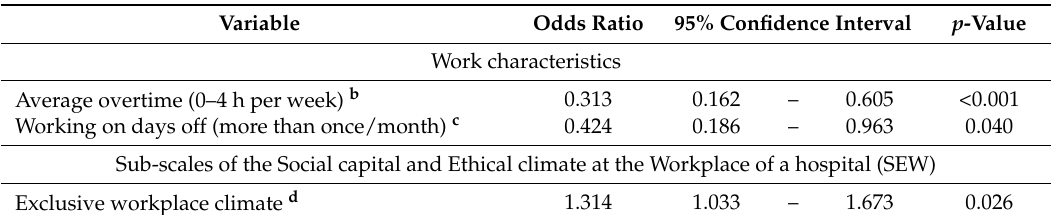
Table 5. Multivariate logistic regression model for the experience of work-related accidents or injuries in the last half year ( n = 822) a .